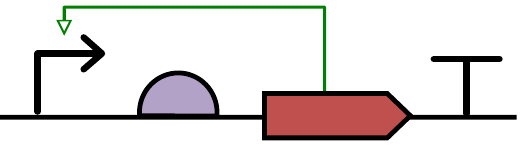
Figure 16: Example of an interaction indicating a promoter stimulated by the CDS that it